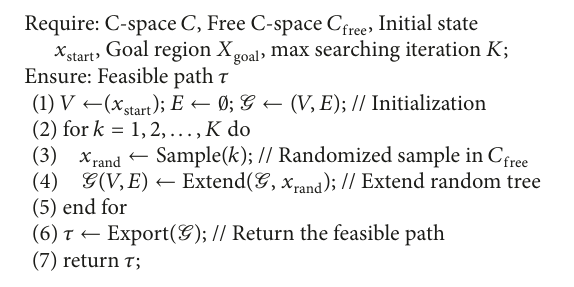
Algorithm 1: Body of basic RRT algorithm